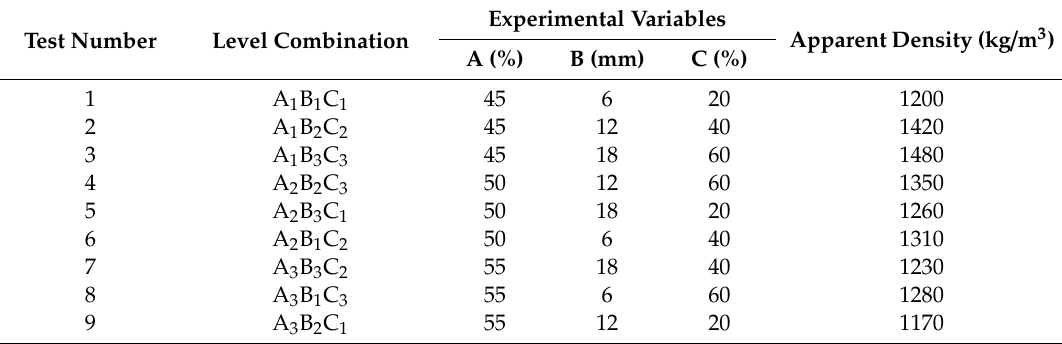
Table 2. Statistics pertaining to the calculated apparent